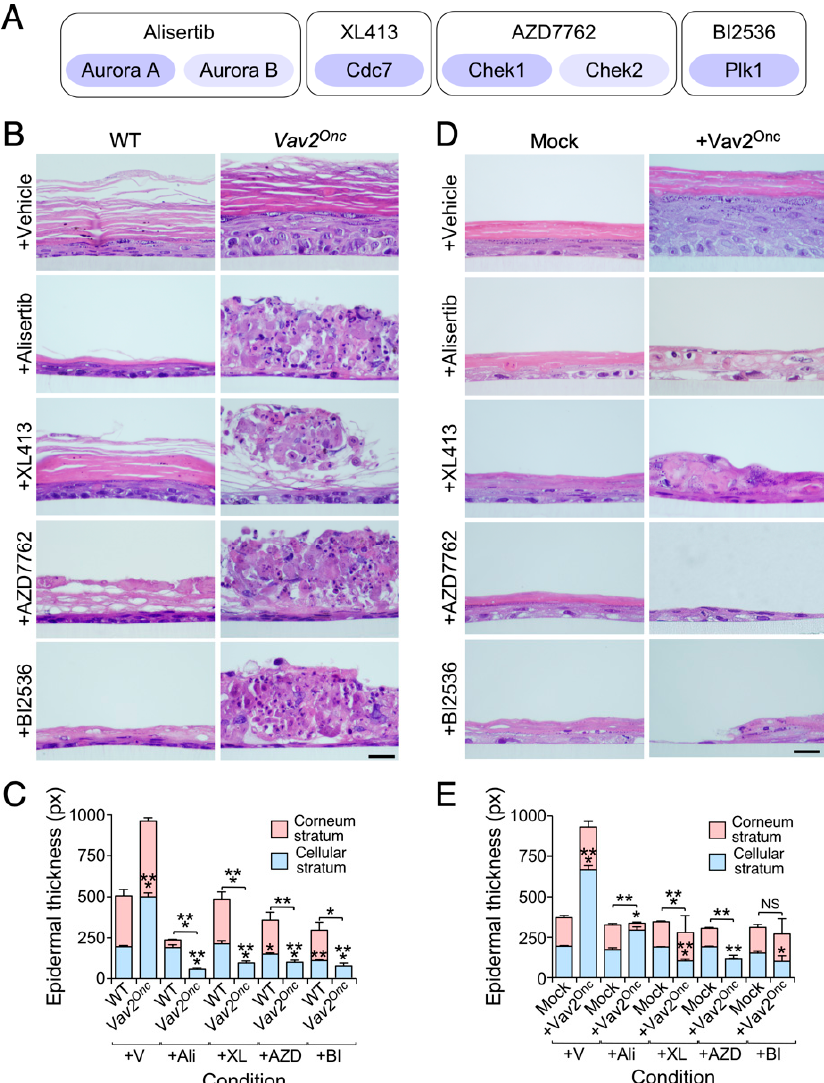
Figure 3. VAV2 upregulation leads to vulnerability against cell cycle inhibitors. ( A ) Scheme indicating the targets for each of the drugs used in this study. Primary and secondary targets are indicated in dark and light blue, respectively. ( B ) Representative hematoxylin-eosin tissue sections from organotypic cultures using the primary mouse keratinocytes of the indicated genotypes (top) upon treatment with the indicated drugs (left). Scale bar, 10 µm ( n = 3). WT, wild-type. Vav2 Onc ; Vav2 Onc/Onc mice. ( C ) Quantification of the thickness of the indicated epidermal strata according to the data obtained in panel B. *, p < 0.05; **, p < 0.01; ***, p < 0.001 (ANOVA and Tukey’s HSD test, n as in panel B). V, vehicle; Ali, Alisertib; XL, XL413; AZD, AZD7762; BI, BI2536. ( D ) Representative hematoxylin-eosin tissue sections from organotypic cultures using the KerCT human keratinocytes expressing the indicated proteins (top) upon treatment with the indicated drugs (left). Scale bar, 10 µm ( n = 3). ( E ) Quantification of the thickness of the indicated epidermal strata according to the data obtained in panel D. NS, not significant; *, p < 0.05; **, p < 0.01; ***, p < 0.001 (ANOVA and Tukey’s HSD test, n as in panel D). Abbreviations are as in C. In C and E, data represent the mean ± SEM .